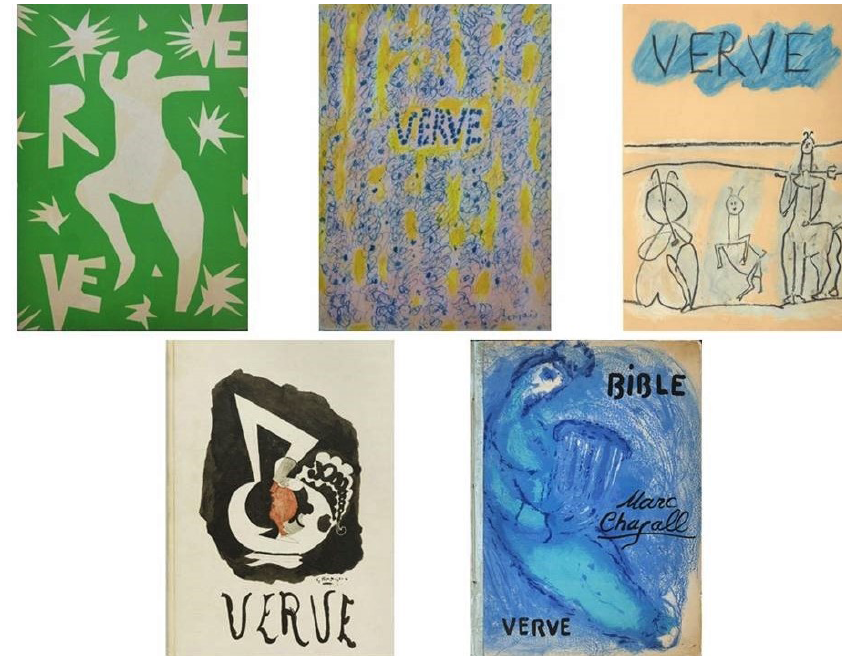
Fig. 6 Couvertures des no. 13 (1945), 17–18 (1947), 19–20 (1948), 27–28 (1953), et 33–34 (1956), illustrés respectivement par Henri Matisse, Pierre Bonnard, Pablo Picasso, Georges Braque et Marc Chagall, © Succession Picasso 2019, Σ Δ EETE [OSDEETE], 2019 © ADGP, Paris, O